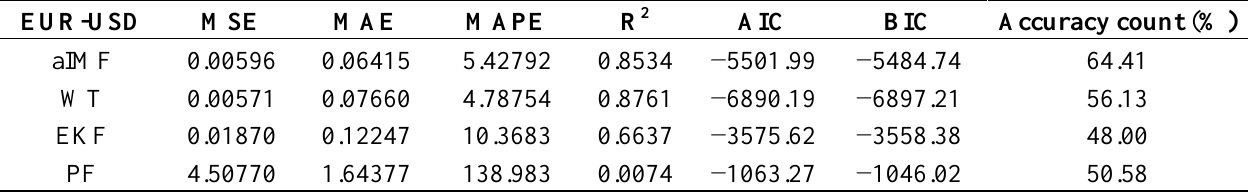
Table 4. Performance measurements of original datasets using noise distribution at 100% with 5 Hz and 20% amplitude of the original signals.